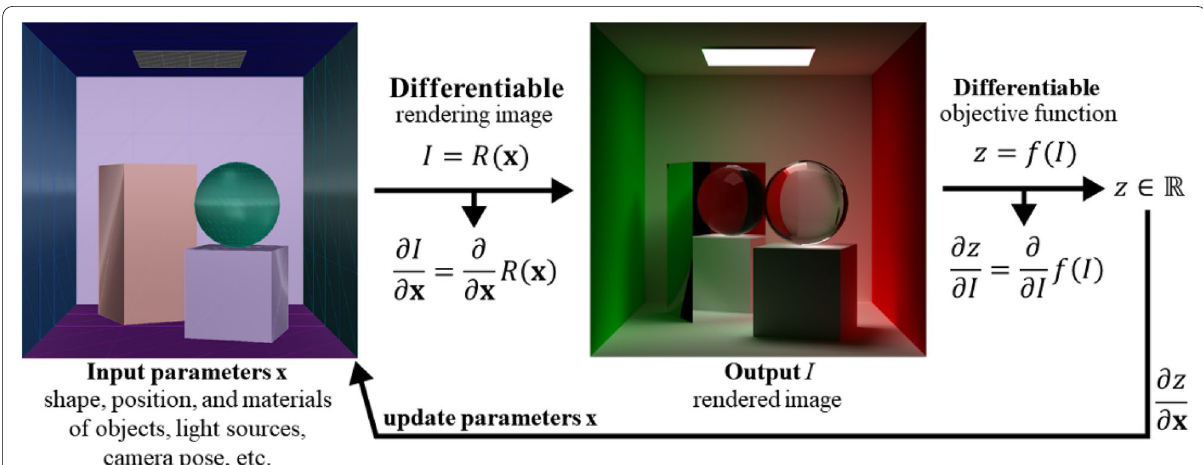
Fig. 33 Rendering a scene can be interpreted as a function R ( x ) where the input is the parameters of the scene, lighting and camera, and the output is the rendered image. Using differentiable rendering allows us to obtain gradient information from the image to the parameters of the scene to apply the gradient descent algorithm to optimize these